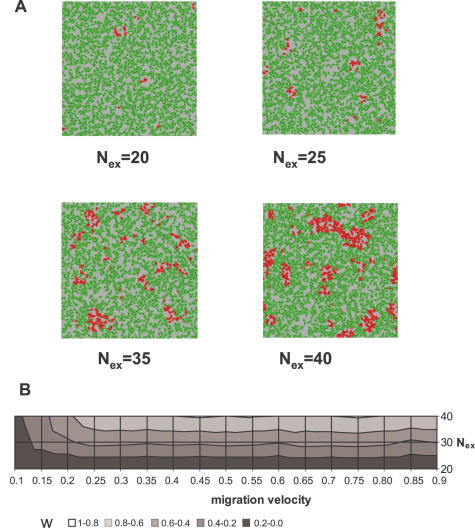
The “extrinsic” model.
A: Simulations with the “extrinsic” model using increasing values of Nex. Note the increasing proportion and clustering of type A (red) cells with increasing Nex. In all simulations Nmax death = 40 was used. B: Analysis of type A cell distribution as a function of average migration velocity and varying Nex using the standardized nearest neighbour distance. Type A cells were clustered (w<1) at all but small average velocity values at all Nex values analysed.